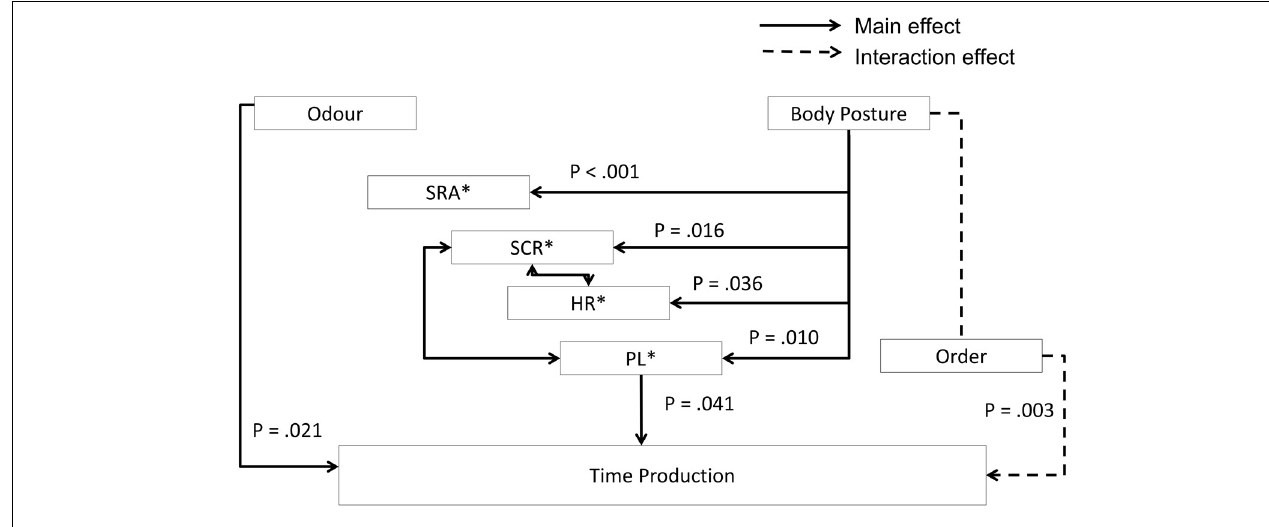
FIGURE 3 | Overview of the